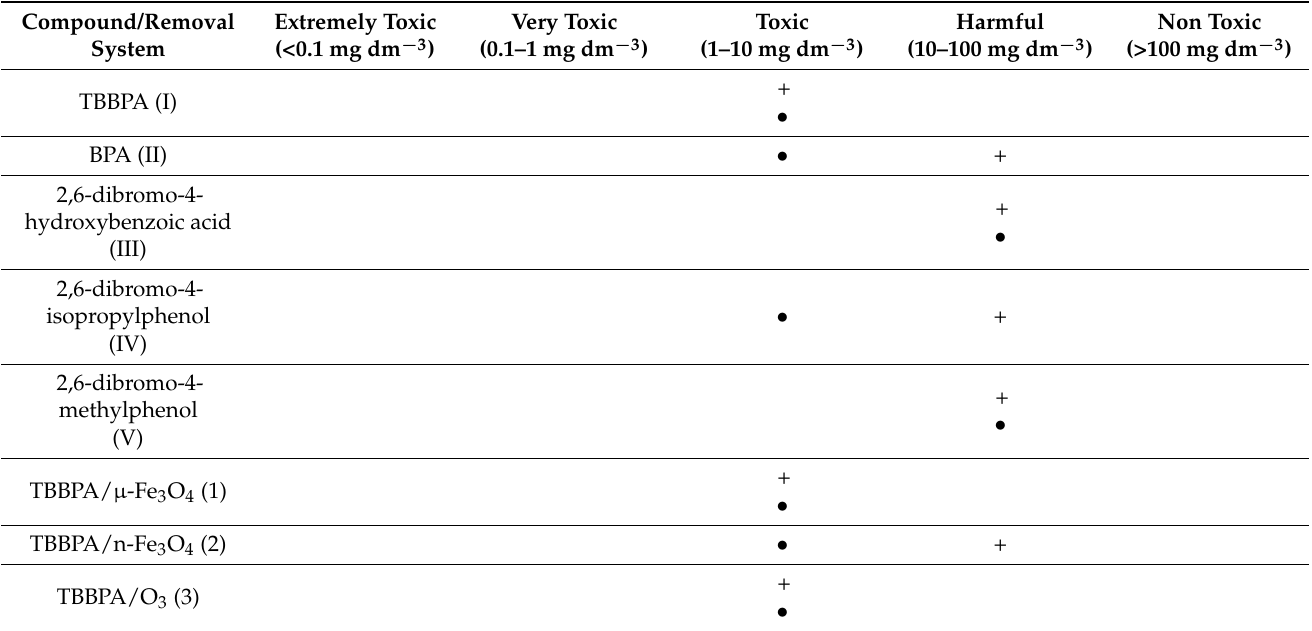
Table 3. Toxicity of TBBPA and its by-products based on European Union Commission Guideline 93/67/EEC classification [36] and estimated EC 50